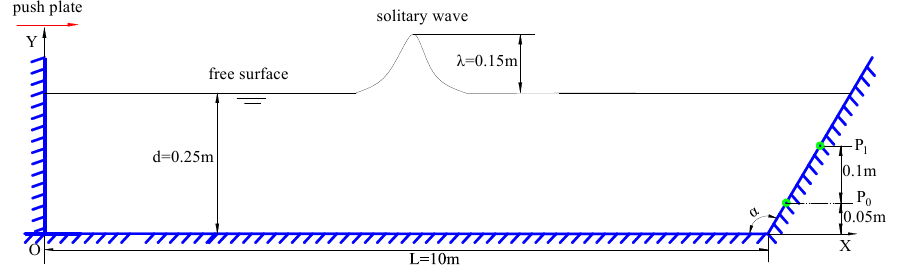
Figure 10. Schematic view of the solitary wave tank.